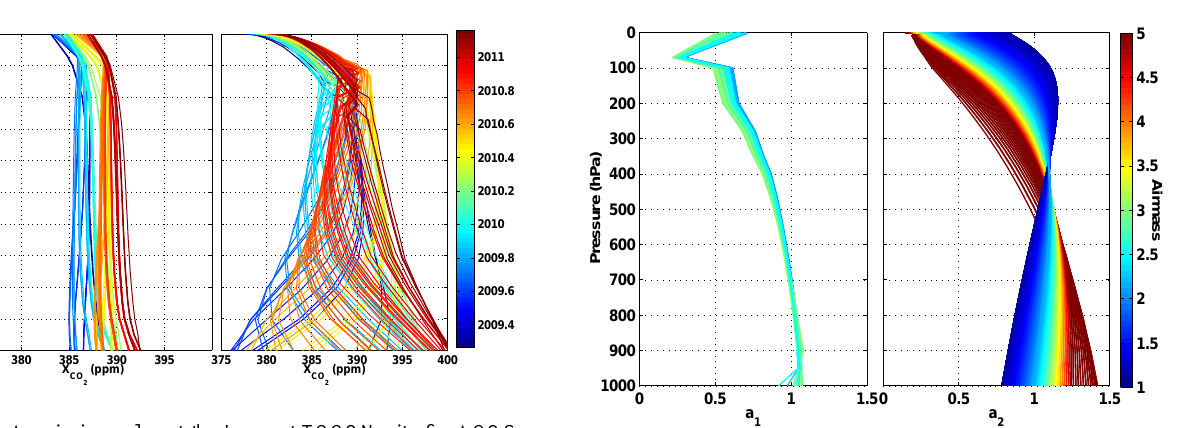
Fig. A1. A priori profiles at the Lamont TCCON site for ACOS- GOSAT (left panel) and TCCON (right panel), coloured by the year.